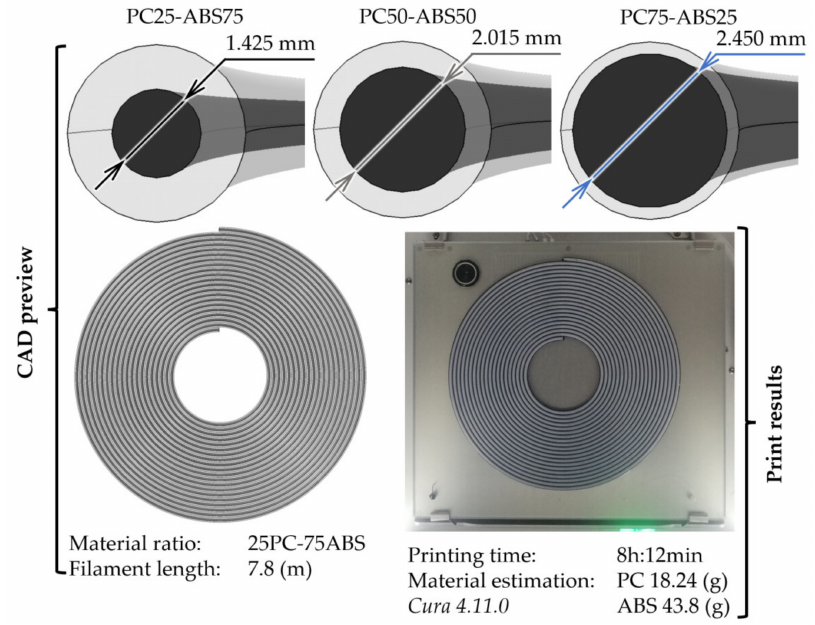
Figure 2. From CAD design to 3D printed core-shell filaments. All three filaments were produced with similar parameters settings, with a 0.4 mm nozzle, 0.15 mm layer height, a line width of 0.35 mm, and 35 mm/s printing speed. However, to print the 75PC-25ABS filament’s shell, a smaller nozzle was necessary (i.e., 0.25 mm) and a line width of 0.2 mm. As shown in Figure 3, the resulting core-shell interface does not have a circular profile because the slicing tool alternates (zig-zagging) the core and shell lines to increase horizontal and vertical adhesion between walls, improving the materials’ bond.